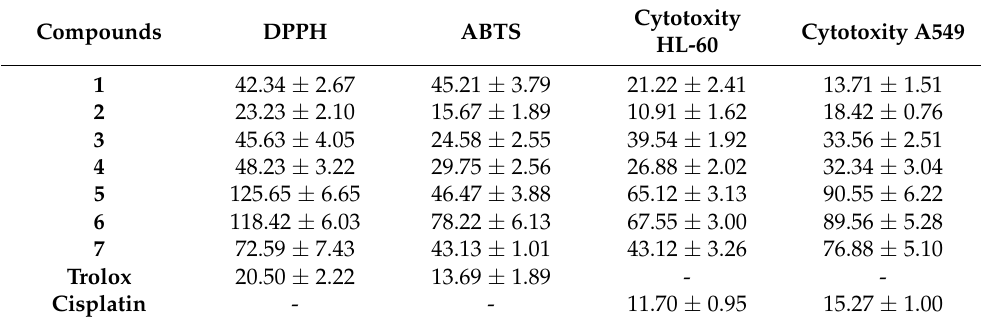
Table 2. Antioxidant and cytotoxic activities of compounds 1 – 7 . Compounds DPPH